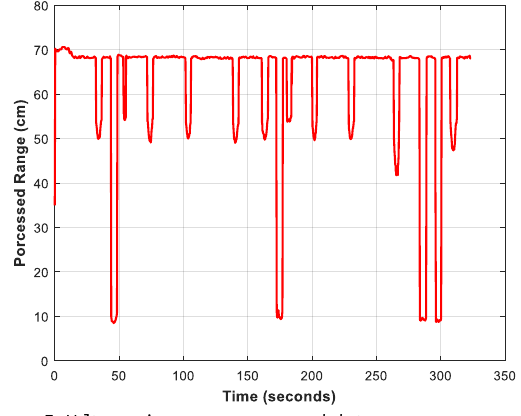
Figure 5. Ultrasonic sensors processed data